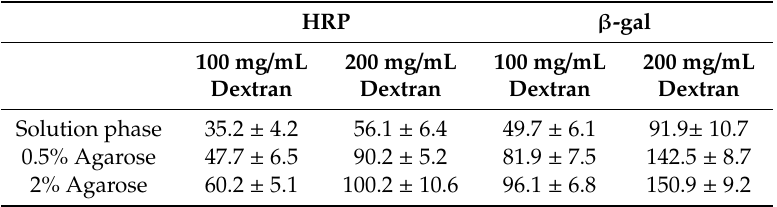
Table 2. Percent increase in half-lives of enzymes encapsulated in agarose–dextran a hybrid gels (prepared using low-molecular-weight dextran) relative to solution-phase enzymes.